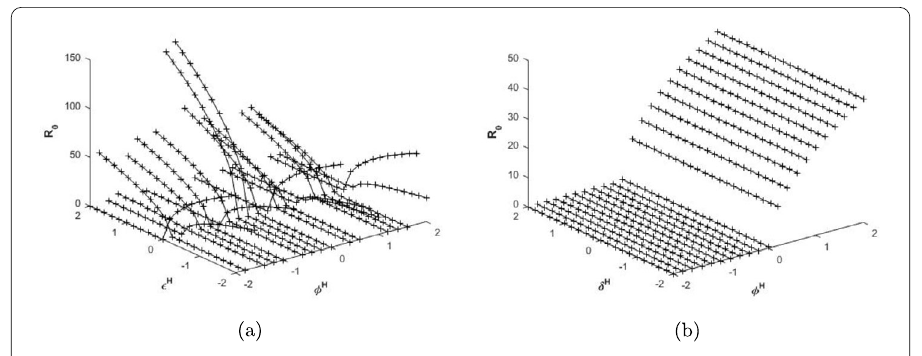
Figure 9 Influence of φ H , (cid:6) H and φ H , δ H on R 0